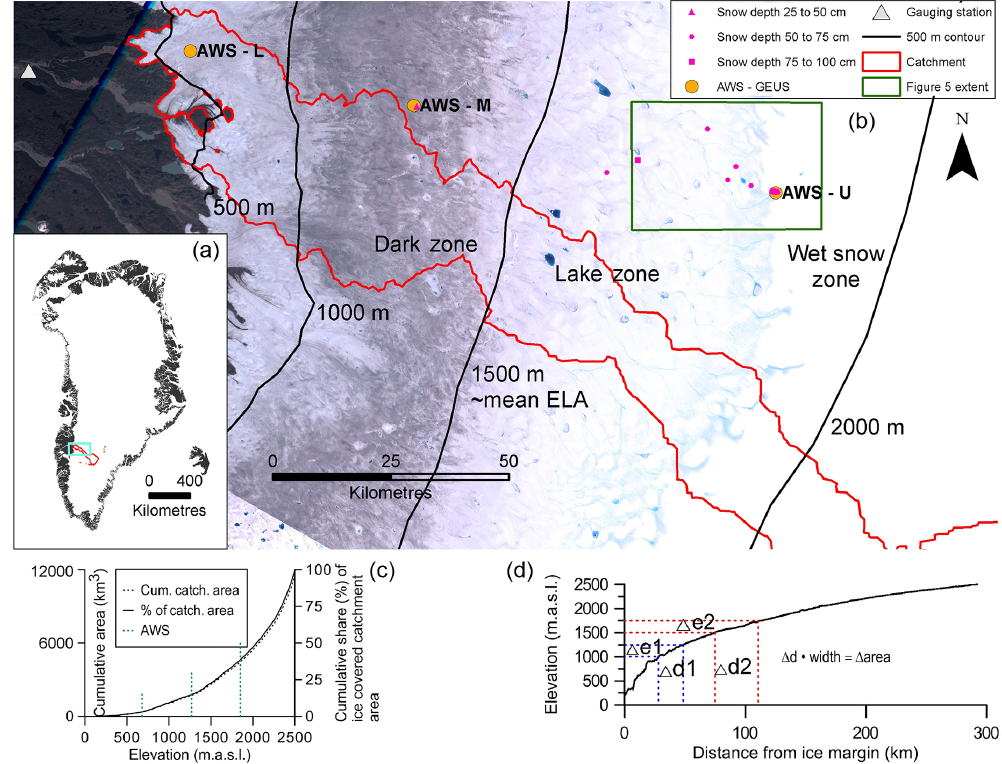
Figure 1. Panel (a) shows the location of the study area (cyan) and catchment (red) in Greenland is shown on the inset map. Panel (b) shows the map of the study area overlain with the location of the AWS, gauging station, catchment area and snow pit sites. The background Landsat 7 image, which was acquired on 16 July 2012, reveals that superglacial lakes and streams formed at an exceptional and unprecedented elevation of ∼ 1800ma.s.l. The non-linear increase in the size of the catchment with increasing elevation is shown in (c) , and (d) shows an example of the impact on melt area with a rise in the snow line of 250m with a 500m displacement in different start elevations (hypsometric